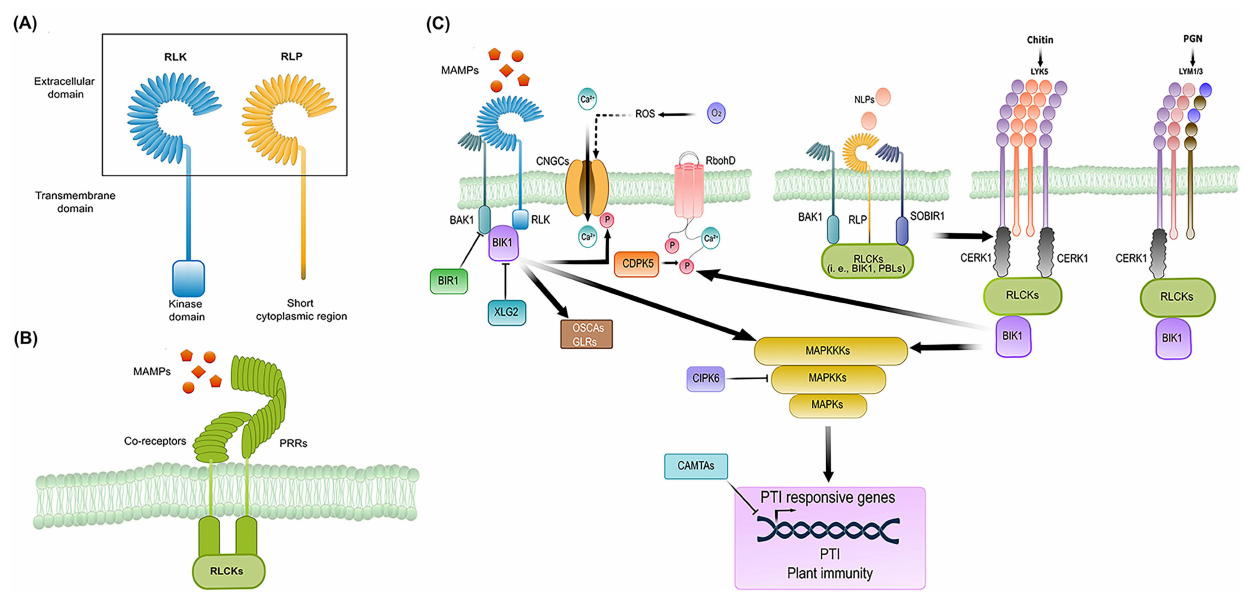
Figure 2. An overview of PRR-mediated PTI. ( A ) Classification of PRRs as RLKs and RLPs according to their structural differences in the intracellular region. ( B ) Ligand-dependent interactions of PRRs with co-receptors and RLCKs. ( C ) An outline of the PRR-triggered signaling cascade that leads to PTI is depicted. At the level of early signaling, BAK1, SOBIR1, and CERK1 are canonical co-receptors of PRRs (RLKs and RLPs). Then, the signal is transduced and integrated by RLCKs to downstream modules such as kinases, RBOHs, CNGCs, among others. See the main text for details. Section 2A and part of 2C were adapted with permission from [20,25], respectively. Created with Inkscape (https://inkscape.org) and GIMP v2.10.24